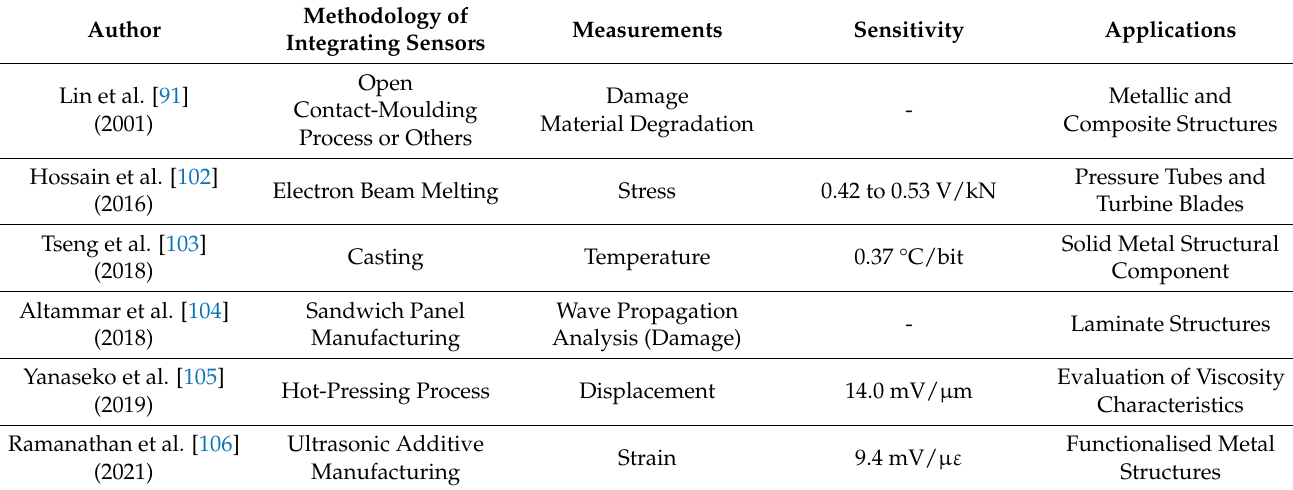
Table 7. Overview of applications and methodology of integrating different types of sensors such